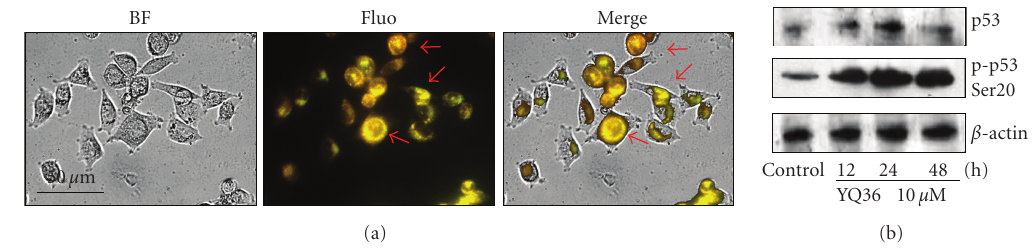
Figure 6: YQ36-mediated DNA damage in KB/VCR cells. (a) The YQ36 accumulated in nucleus was detected by fluorescent microscope and the arrow indicated that YQ36 accumulated in nucleus. (b) Upregulated p-p53 was detected in YQ36-induced DNA damage by Western